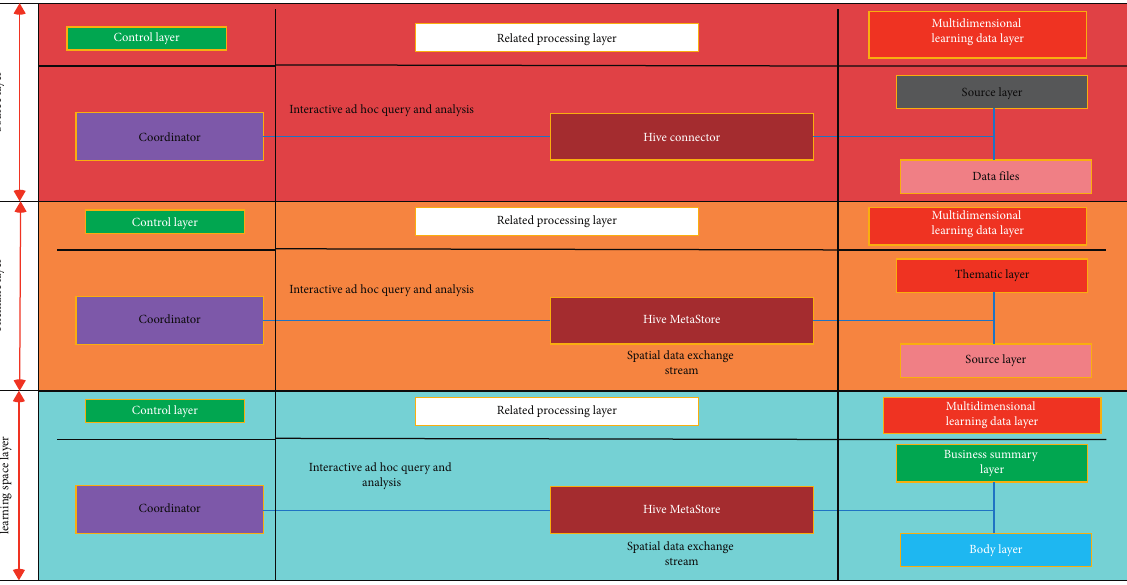
Figure 2: Processing of Presto